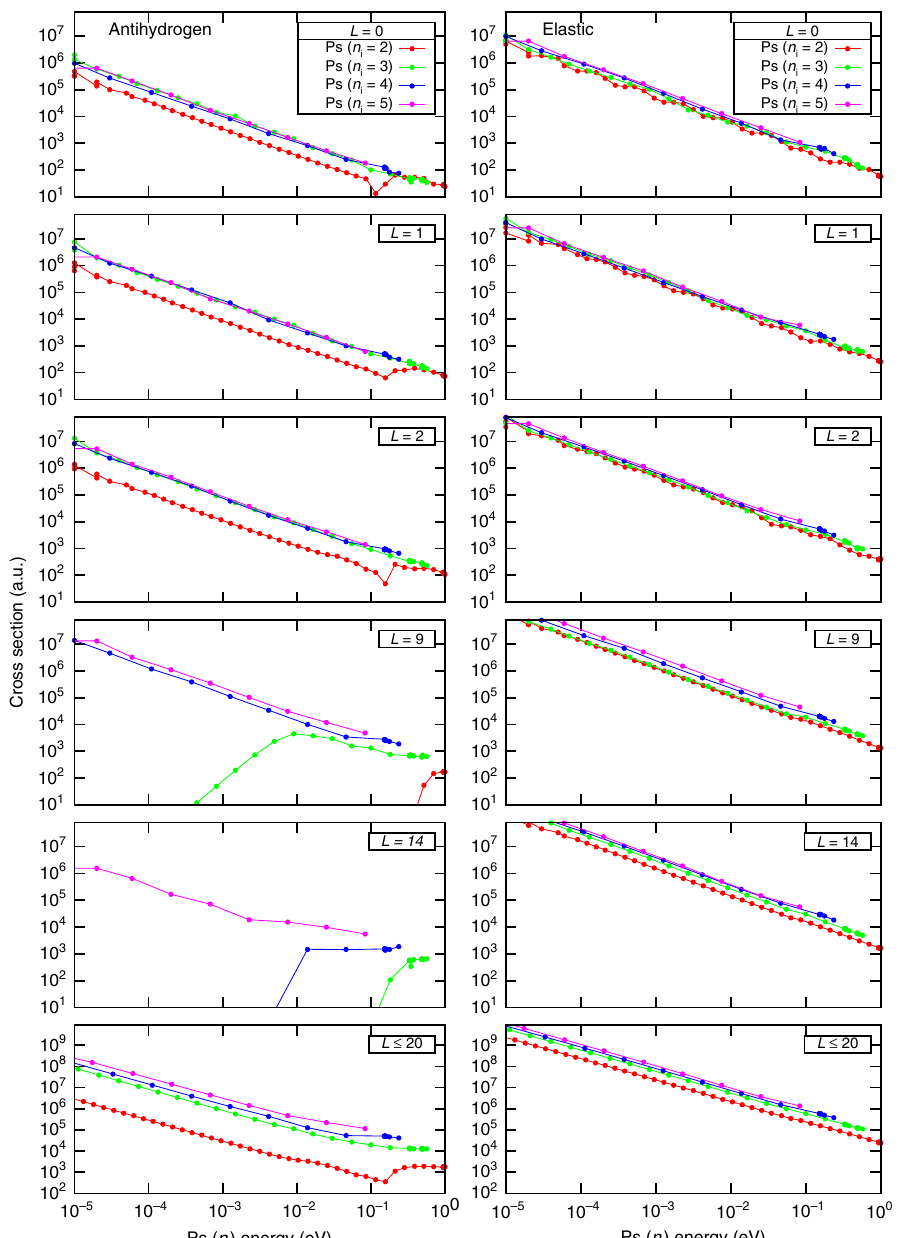
Fig. 1 Antihydrogen-formation and elastic-scattering cross-sections. Cross-sections for Ps( n i , l i )+ p reactions leading to H formation (left) and elastic scattering (right) in atomic units (a.u.), where 1 a.u. is ~2.7×10 − 21 m 2 . The data are summed across the angular momentum manifold (0 ≤ l i ≤ n i − 1) for each speci fi ed n i